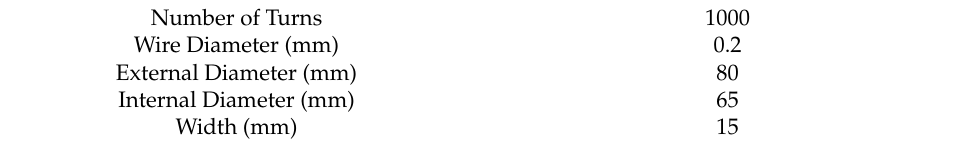
Table 6. Main characteristics of the current clamp.